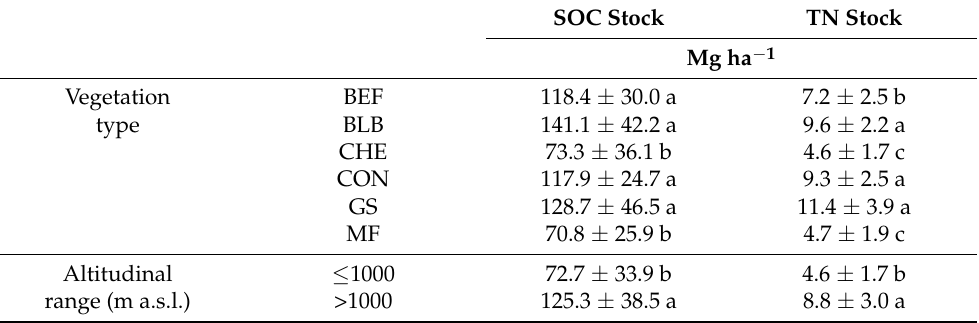
Table 7. Mean ± standard error of soil organic carbon stock (SOC stock) and total nitrogen stock (TN stock) in chestnut groves (CHE), coniferous forests (CON), beech forests (BEF), blueberry habitat (BLB), mixed forests (MF), and grasslands (GS) and at 400–1000 and 1000–2134 m above sea level (a.s.l.). For the vegetation types and altitudinal ranges, different letters within each column indicated significant differences (Kruskal–Wallis test, p <